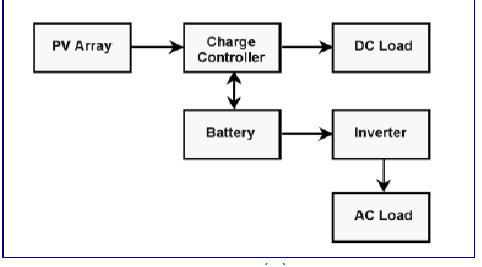
fig1: PHOTOVOLTAIC SYSTEMS –Standalone